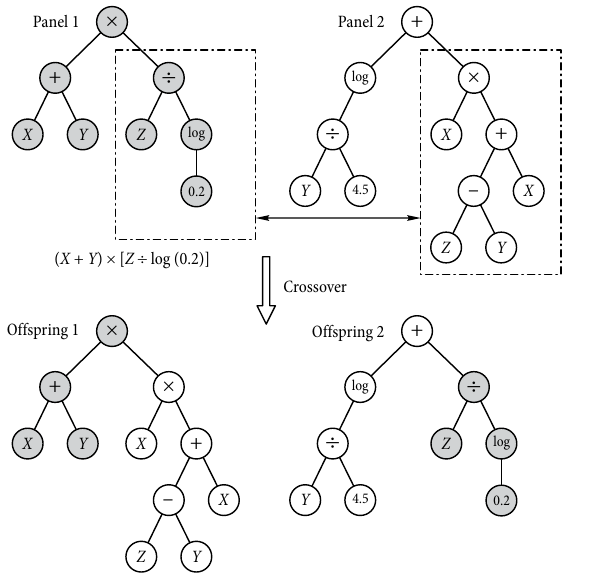
Fig. 1. Crossover operation in GP Fig. 2. Mutation operation in